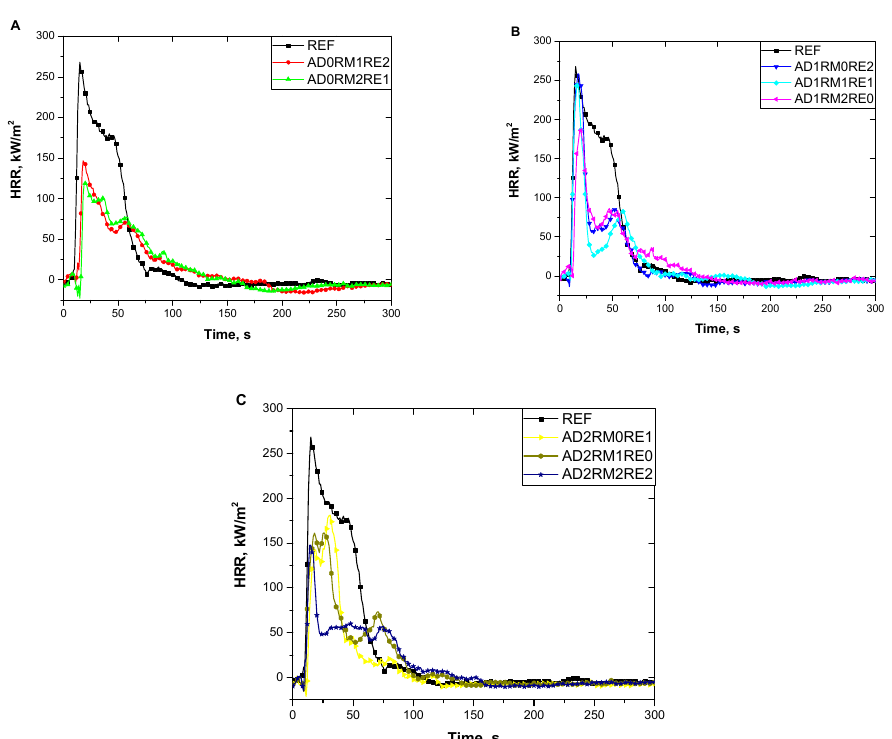
Figure 8. HRR curves of the obtained polyurethane foams without the addition of AD ( A ), containing 10% AD ( B ), containing 20% AD ( C ) from cone calorimetry. A correlation was observed between the LOI and the THR value from the pyrolysis combustion flow calorimetry. When the values of the LOI of the obtained PURFs increase, the TTR (PCFC test) decreases (Figure 9A). Such a relationship was also observed in an- other study [64]. There is also a relationship between the LOI and THR from cone calo- rimetry. For the foams obtained, when the value of the LOI increases, the THR from the cone calorimeter test decreases (Figure 9B). The correlation is also visible between the HRC parameter obtained from the PCFC test, which determines the material's ability of heat emission, and the MARHE parameter, which determines the ability to spread fire [65,66]. For foam materials, due to the decreasing HRC, the MARHE value also decreased (Figure 9C).